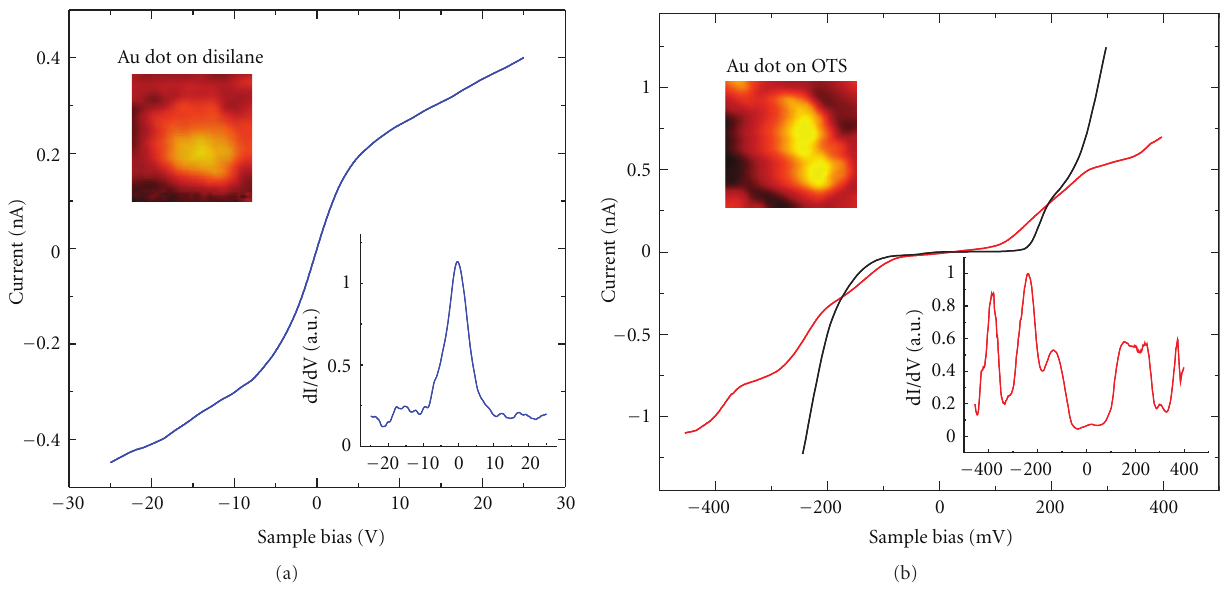
Figure 4: Tunneling I-V characteristics at 4.2K acquired on single 5nm dia. Au NPs deposited on two di ff erent molecular layers self- assembled on a 150 nm superconducting Nb film. (a) On MPdS (di-Silane), showing enhanced zero-bias conductance that reflects strong electrical coupling to the Nb film. Inset: the corresponding dI/dV-V spectrum. (b) On OTS, showing single-electron tunneling e ff ects that indicates weak electrical coupling. Two curves are presented, taken with di ff erent STM settings. The black curve shows a Coulomb blockade, which is removed in the red curve that exhibits a clear Coulomb staircase. Inset: derivative spectrum of the red curve. The voltage-current settings were (a) V set = − 10mV; I set = − 0 . 3nA, (b) V set = − 200 mV; I set = − 0 . 5 and − 0.35 nA, for the black and red curves,